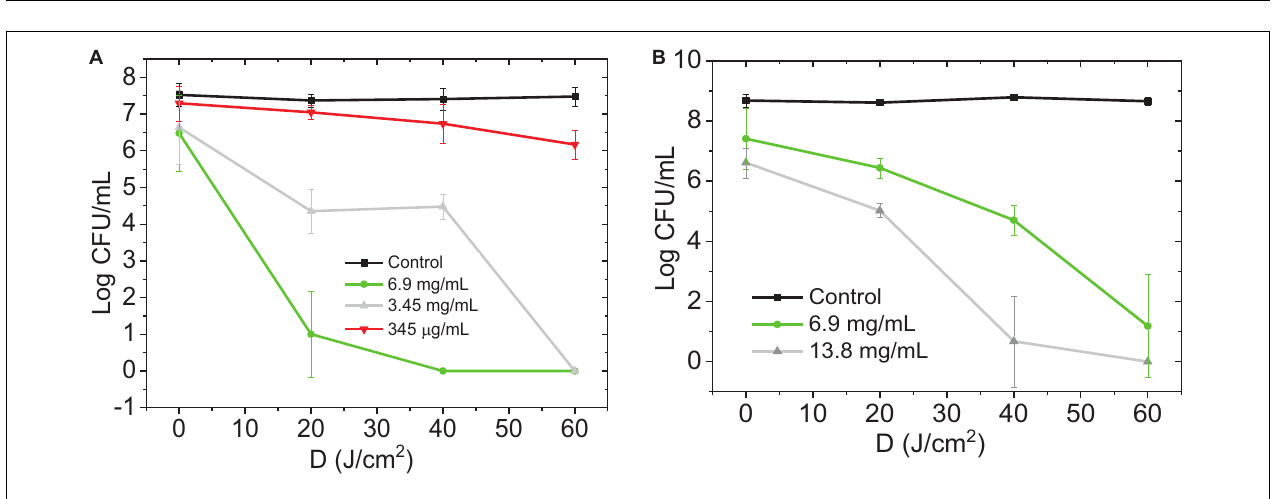
FIGURE 5 | Stability analysis of C-DOTS. (A) Twenty-four hours of photoirradiation at constant temperature (25 ◦ C). (B) Photoirradiation based on temperature, from 25 to 70 ◦ C. λ ex = 450 nm, λ em = 530 nm, pH 5.5.